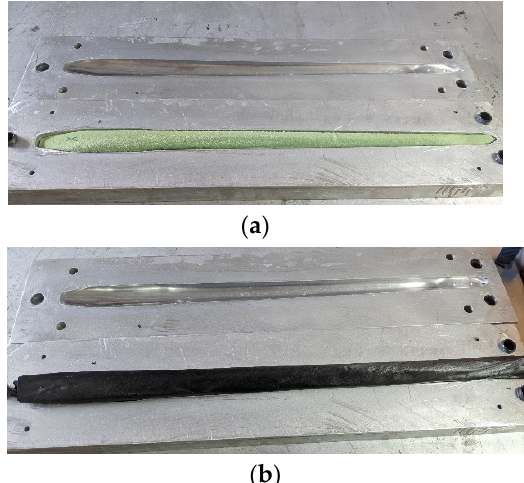
Figure 4. ( a ) PVC core located inside the mould, ( b ) Prepreg sheet laminated the core and fitted inside the mould.